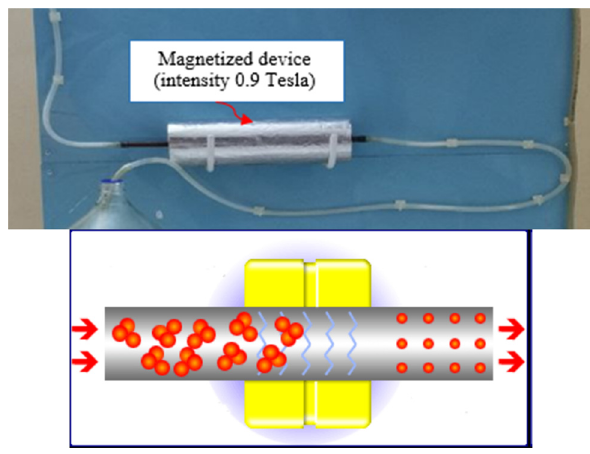
Figure 1: General arrangement of MW